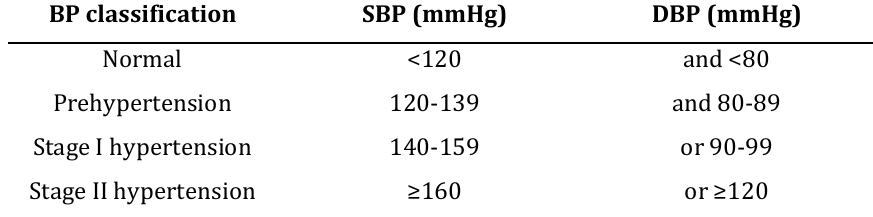
Table 1: Blood pressure classification based on the clinical guidelines recommended in the Seventh Report of the Joint National Committee on Prevention, Detection, and Evaluation